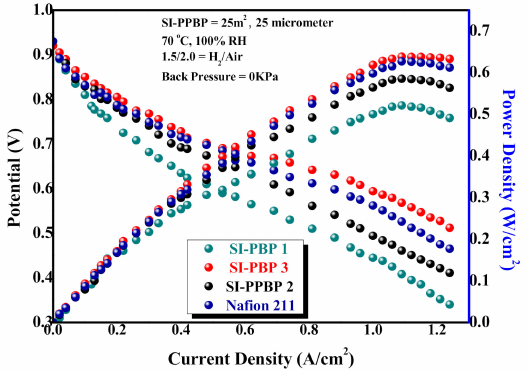
Figure 8. Cell performance for the SI-PBP polymer